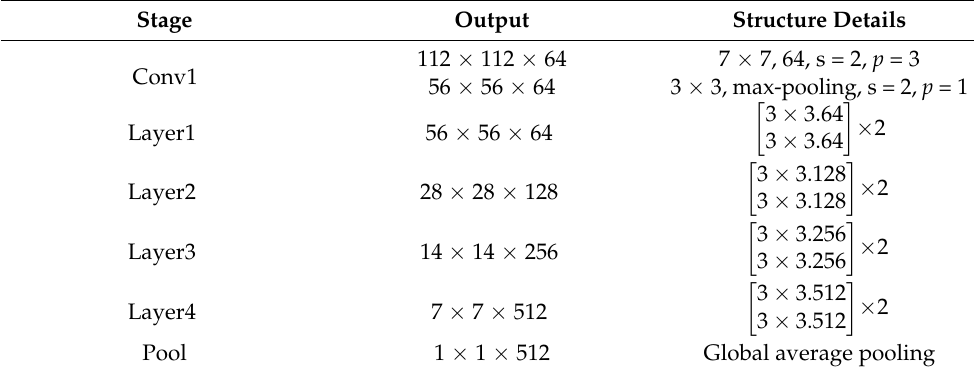
Table 4. Details of the ResNet18